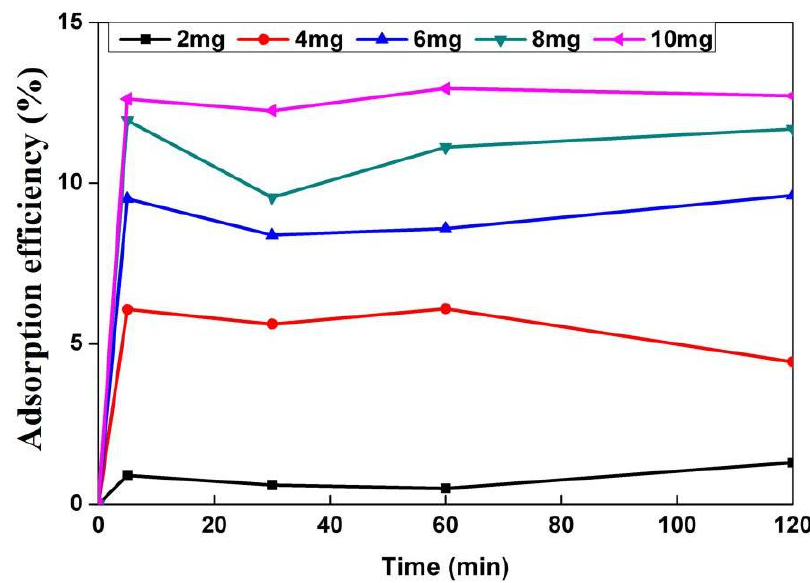
Figure 1. Effect of soil colloid dosage on the sorption of Sr on soil colloids. T = 25 ± 1 °C, C [Sr 2+ ] inital = 100 mg·L −1 , pH = 7 ± 0.1.